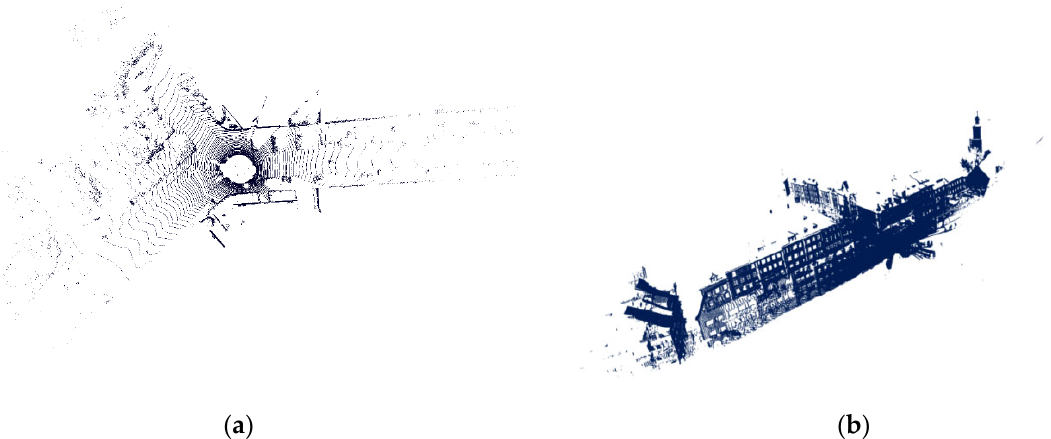
Figure 5. Outdoor point clouds. ( a ) KITTI Odometry Benchmark Velodyne point cloud. ( b ) Market ‐ place reduced.